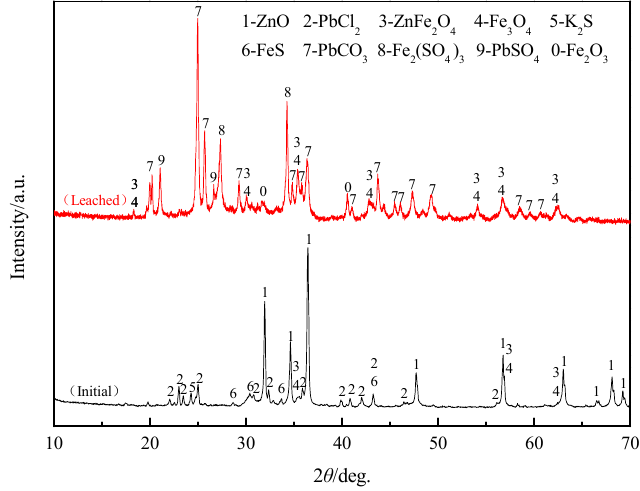
Figure 15. XRD pattern of the initial residue and the leached residue.